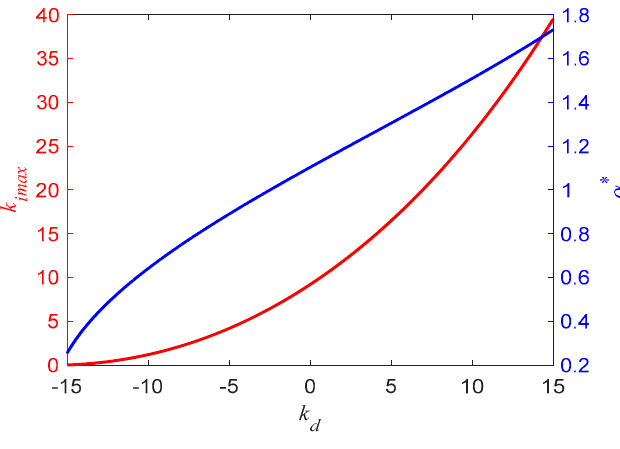
Figure 3. The value of